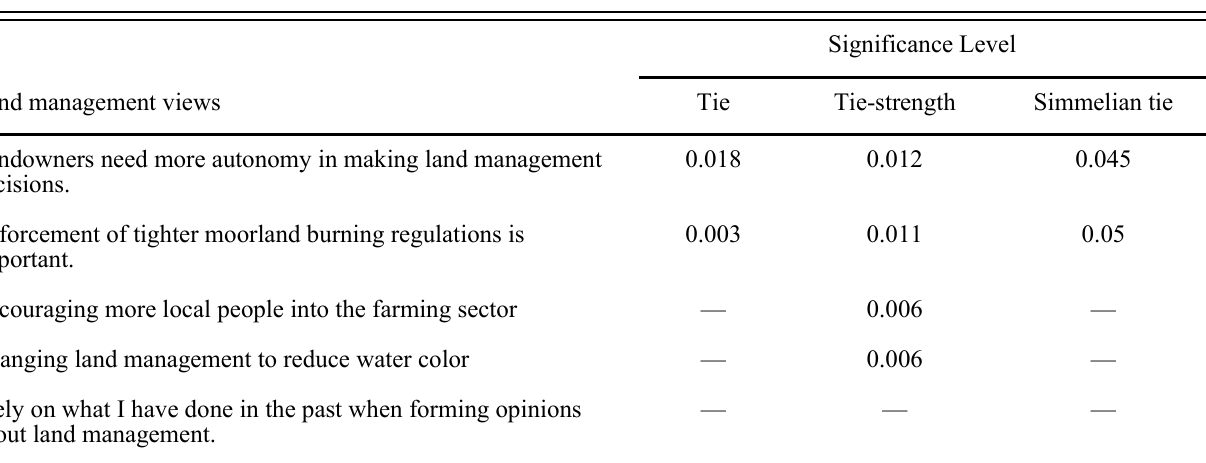
Table 1. Autocorrelations between land management views and social network